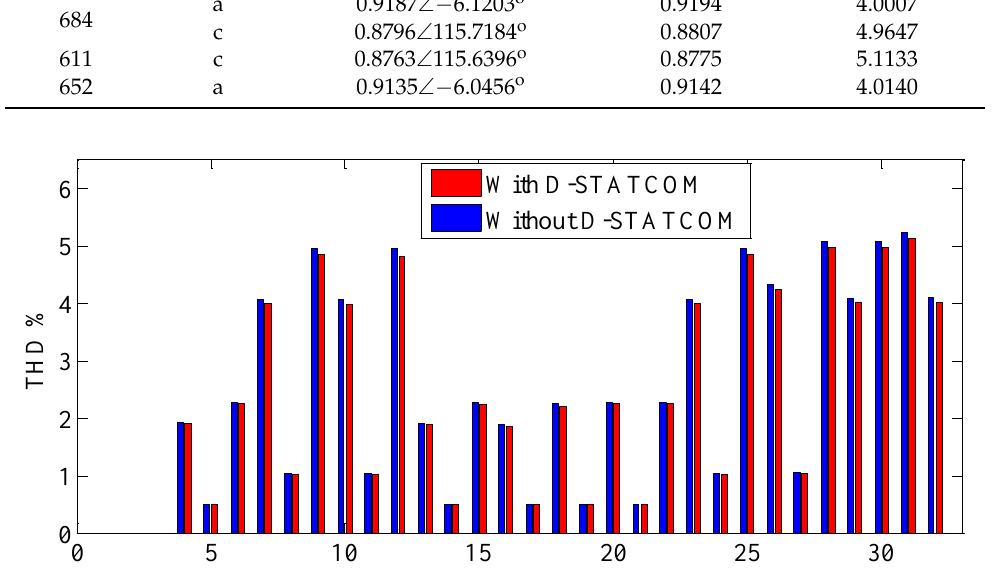
Figure 8. Comparison of THD % for case studies on IEEE−13 URDN.